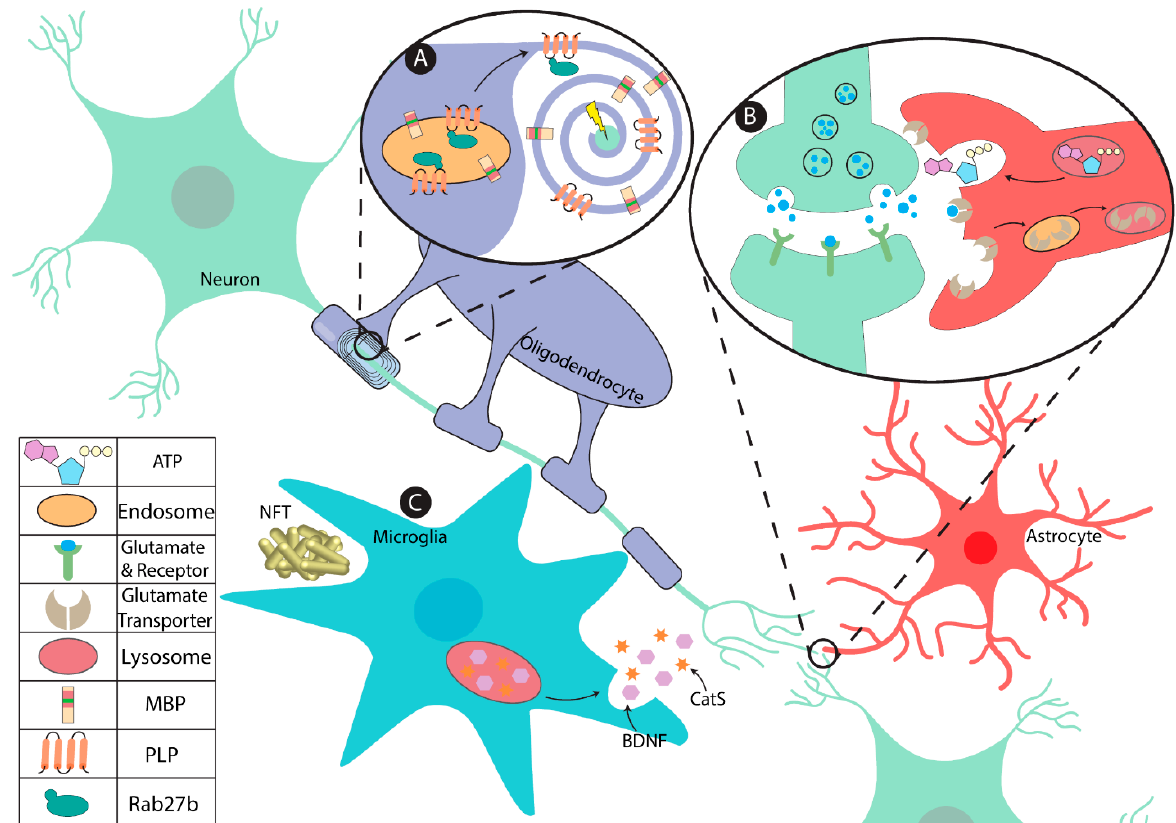
Figure 1. Lysosomal function in the major glial cell types in the central nervous system (CNS). ( A ) Lysosomes are integral in establishing and maintaining proper myelin integrity in oligodendrocytes. The lysosomal/endosomes in oligodendrocytes sort and transport myelin proteins such as PLP, which is co-trafficked by Rab27b, and MBP to the myelin sheath for myelin turnover and plasticity in an activity dependent manner. ( B ) Astrocytic lysosomes are key modulators of the extracellular environment of the synaptic cleft. Their lysosomes secrete ATP, modulating synaptic strength. Furthermore, the recycling of glutamate is mediated via endocytosis from the peri-synaptic membrane, thus influencing synaptic glutamate availability. ( C ) Microglia sequester neurodegenerative substances that accumulate in proteinopathies such as neurofibrillary tangles (NFT) associated with Alzheimer’s disease. Microglial lysosomes are implicit in releasing multiple factors including brain-derived neurotrophic factor (BDNF) and Cathepsin S (CatS) that aid in CNS development, memory formation, and remodeling of the extracellular matrix and synaptic architecture.